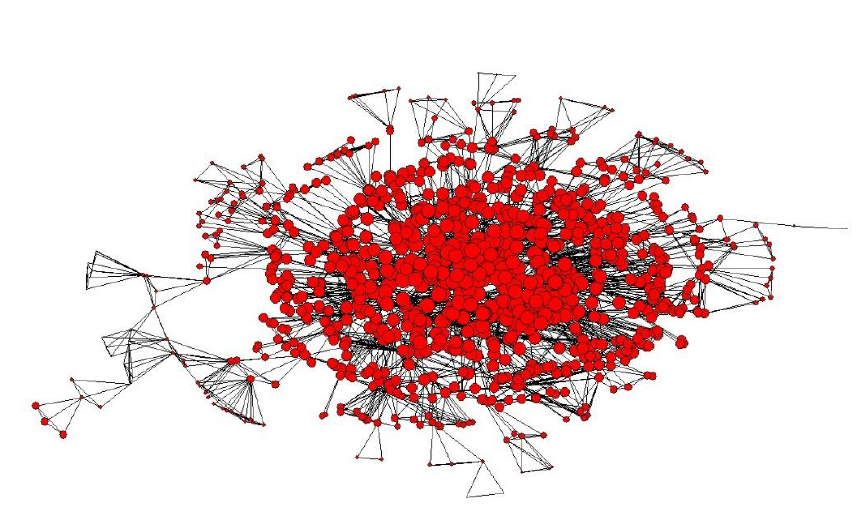
Figure 4. network related to closeness (year: